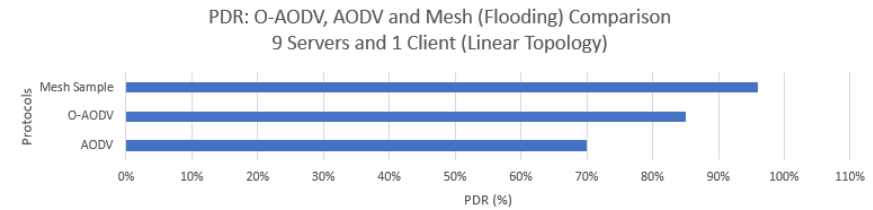
Figure 12. PDR: O-AODV, AODV, and mesh (flooding)